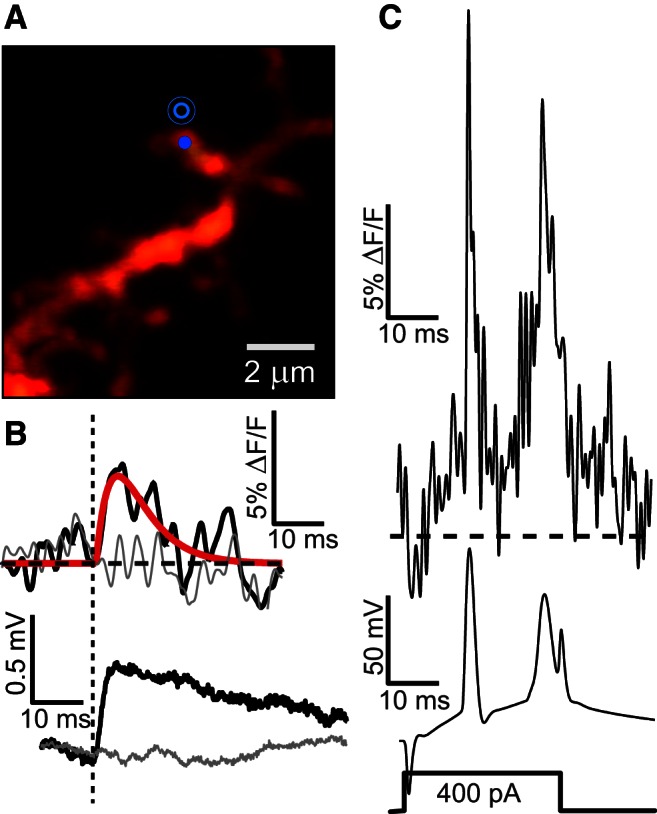
Detection of uncaging spEPSPs using a VSD. A, Z-projection image of basal dendrite region, with spine of interest 92 μm from soma. On-spine recording, and peri-spine uncaging targets shown. B, Simultaneous spine optical (top; spEPSP dark trace) and somatic whole-cell electrical (bottom; soEPSP dark trace, 0.53 mV) recordings of uncaging induced EPSPs. Averaged uncaging sweeps are superimposed on control sweeps (light traces). Red trace is dual-exponential fit to spEPSP. Average of N = 6 sweeps uncaging and control, σnoise = 0.63%. Vertical dashed line indicates time of uncaging pulse (0.5 ms pulses). C, Simultaneous optical (top; same spine) and somatic whole-cell electrical (bottom) recordings of APs (current step depicted below) used for calibration. Averages of N = 10 sweeps APs, 23.6% peak. Same scale bars apply to all optical recordings for ease of comparison.